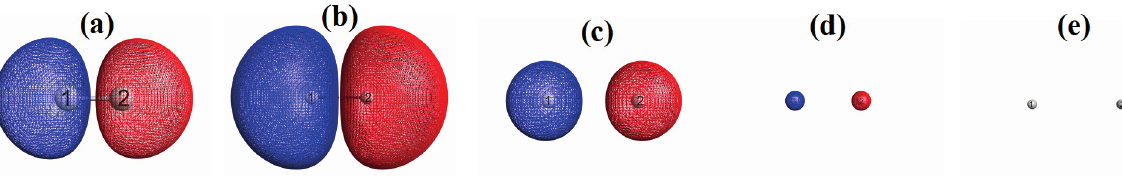
Figure 9. Equivalue surfaces of LRF of UB3LYP solutions for various interatomic